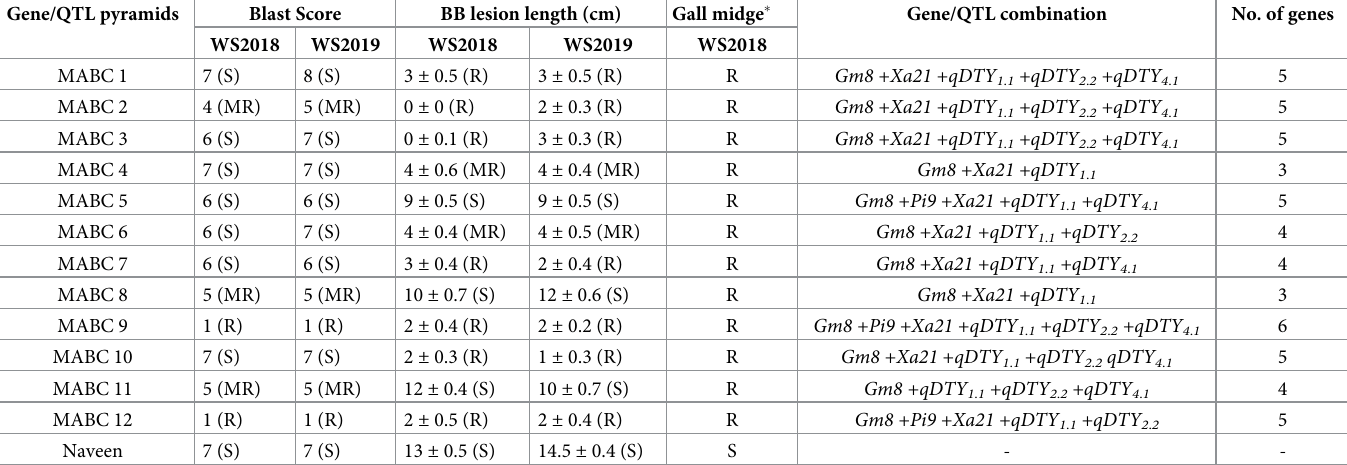
Table 2. Disease reaction (blast, bacterial blight and gall midge) of pyramided lines with different gene/QTL combinations developed through marker assisted back- cross approach. Gene/QTL